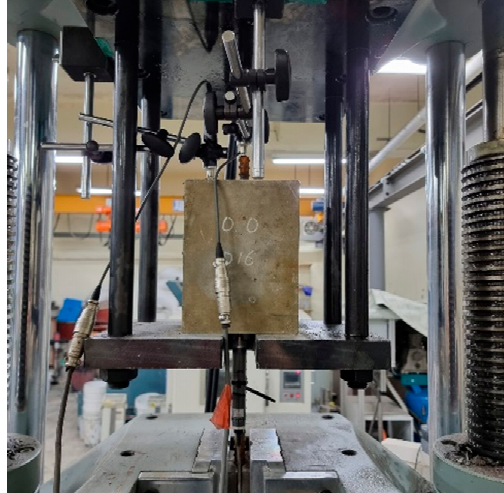
Figure 5. Pull-out test setup.